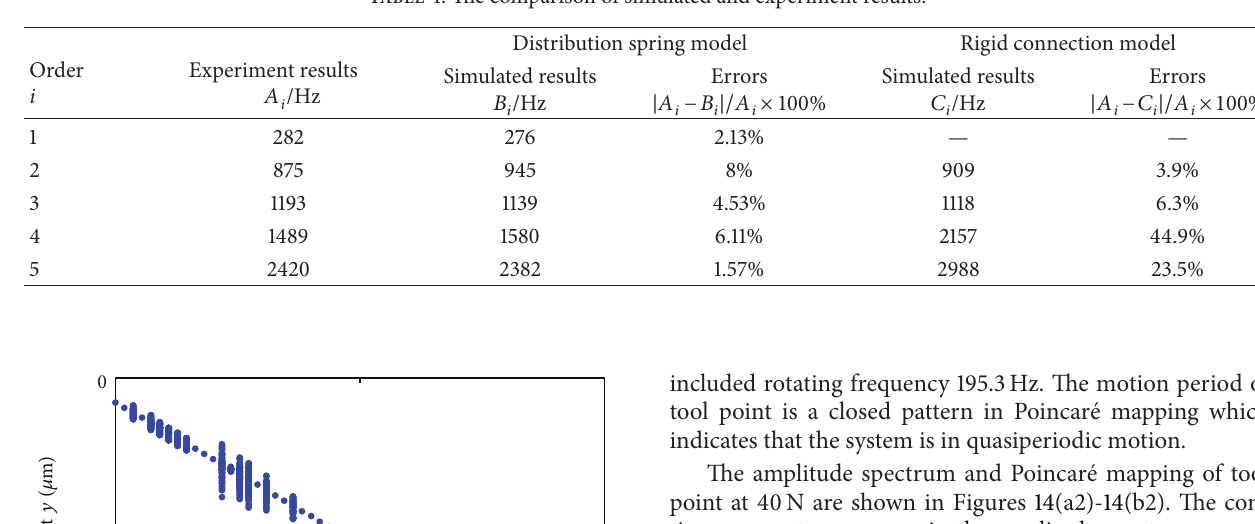
Figure 12: The amplitude diagram and Poincar´e mapping of tool point with different speeds. Table 4: The comparison of simulated and experiment results.